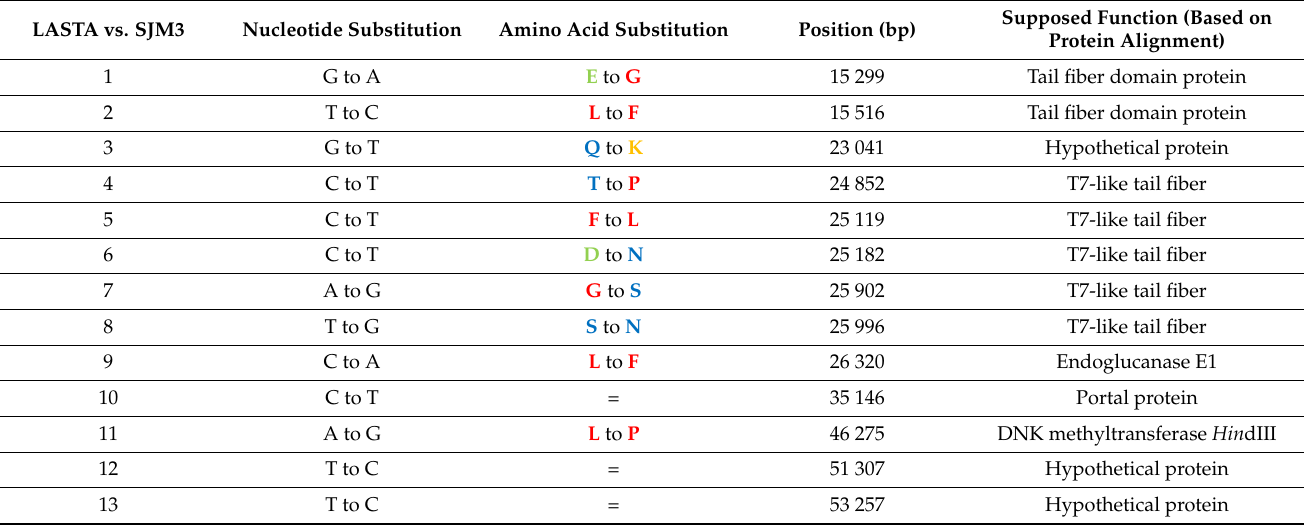
Table 1. Nucleotide and amino acid substitutions in the genomes of LASTA and SJM3. Amino acid classification group: green—negative charge, red—non-polar, blue—polar, orange—positive